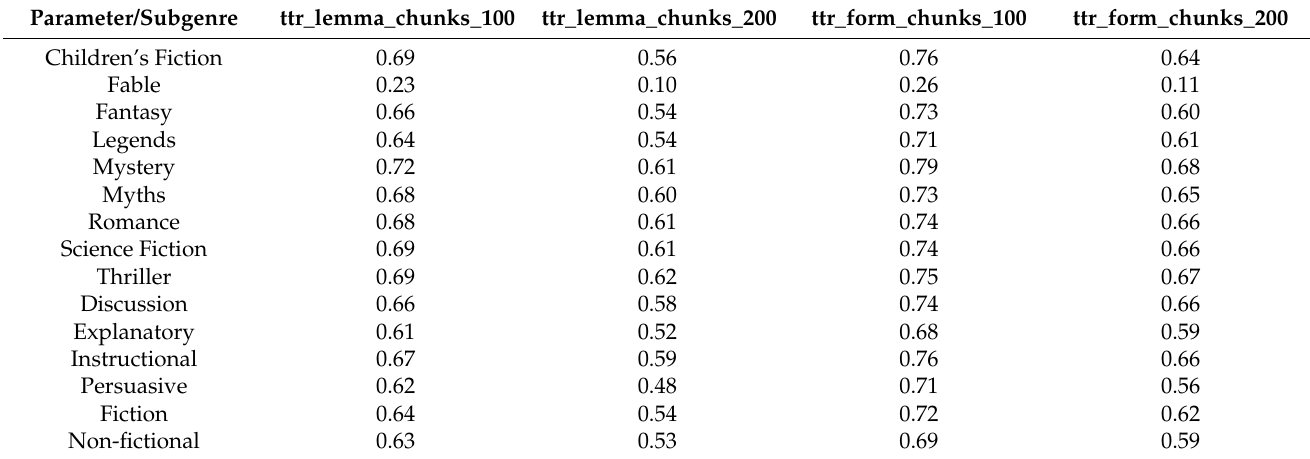
Table 4. Summary of the lexical variety features across